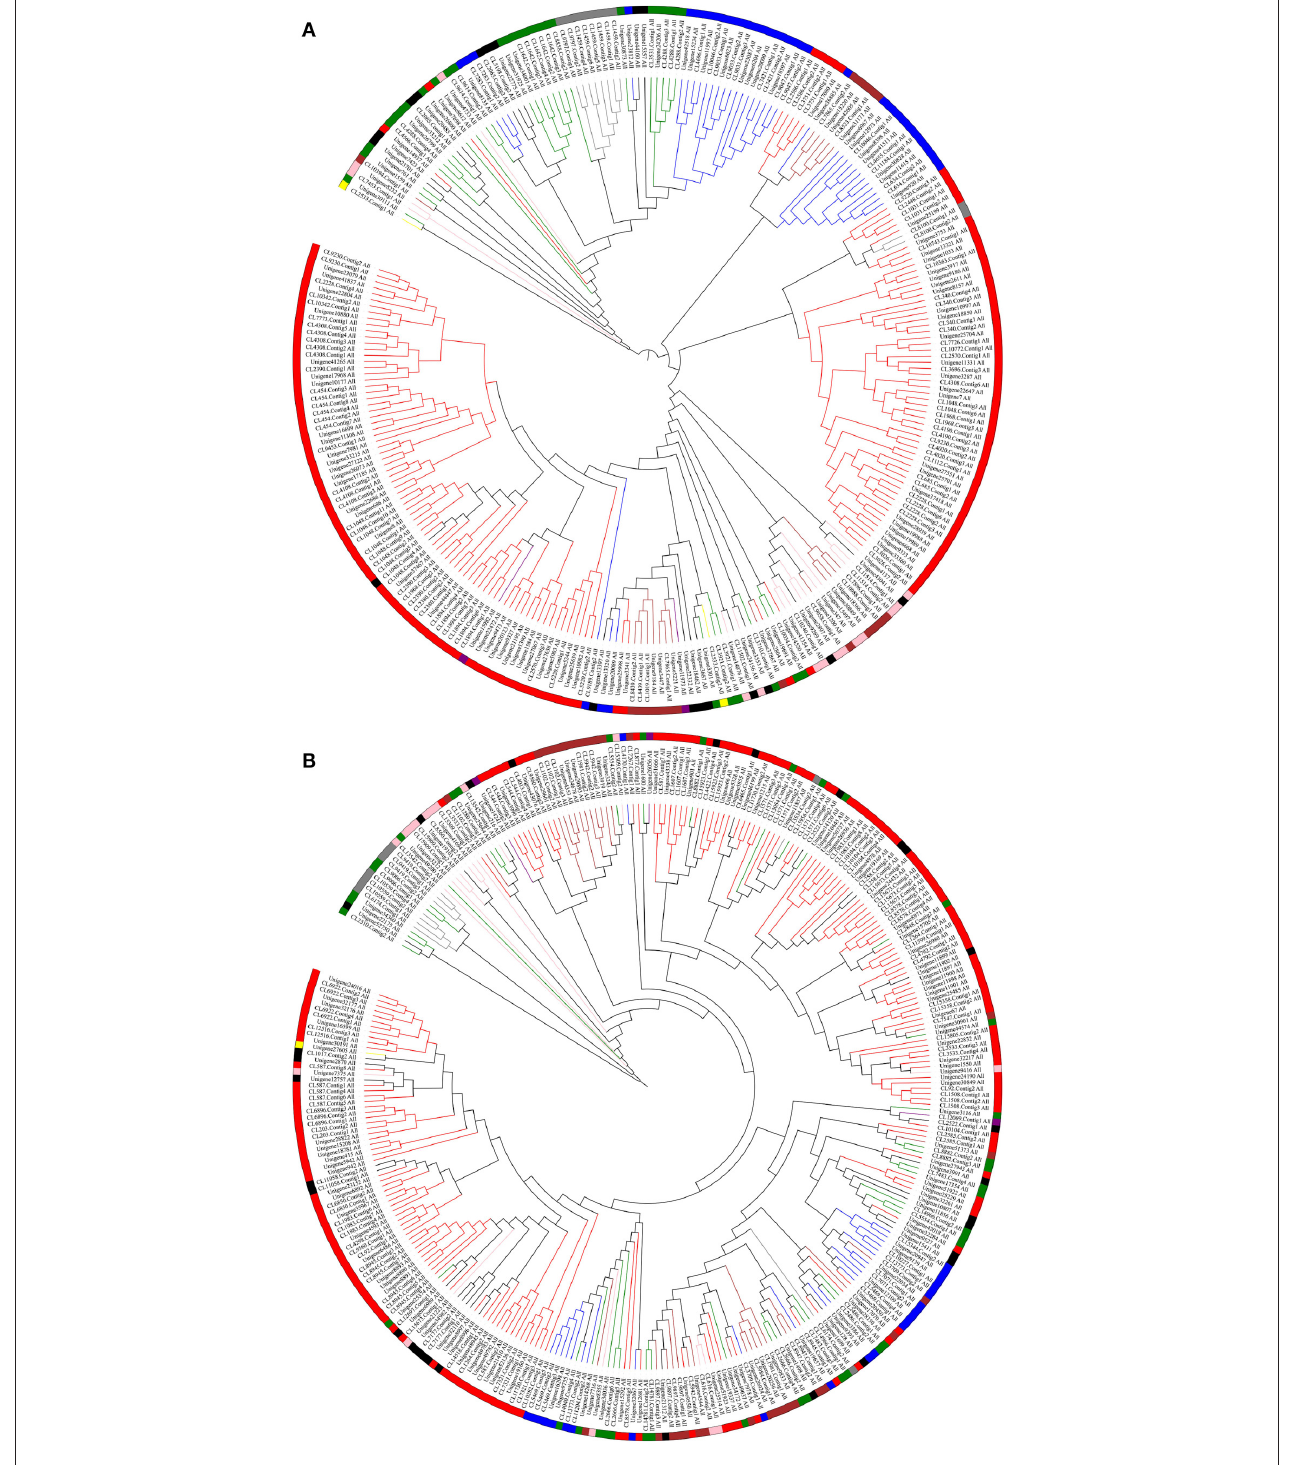
FIGURE 2 | Phylogenetic Tree and Cluster Analyses of the Predicted P450 Transcripts from Perennial Ryegrass and Tall Fescue. Predicted P450 transcripts were aligned using ClustalW (Thompson et al., 2002) and phylogenetic tree was constructed by MEGA6.0 (Tamura et al., 2013) and modified by iTOL (Letunic and Bork, 2016). Different colors indicate different CYP clans. Green, CYP51; red, CYP71; blue, CYP72; yellow, CYP74; pink, CYP85; brown, CYP86; gray, CYP97; purple, CYP710; black, P450 transcripts that cannot be classified into any CYP clan based on the annotation of the trancriptome. (A) , perennial ryegrass; (B) , tall fescue.